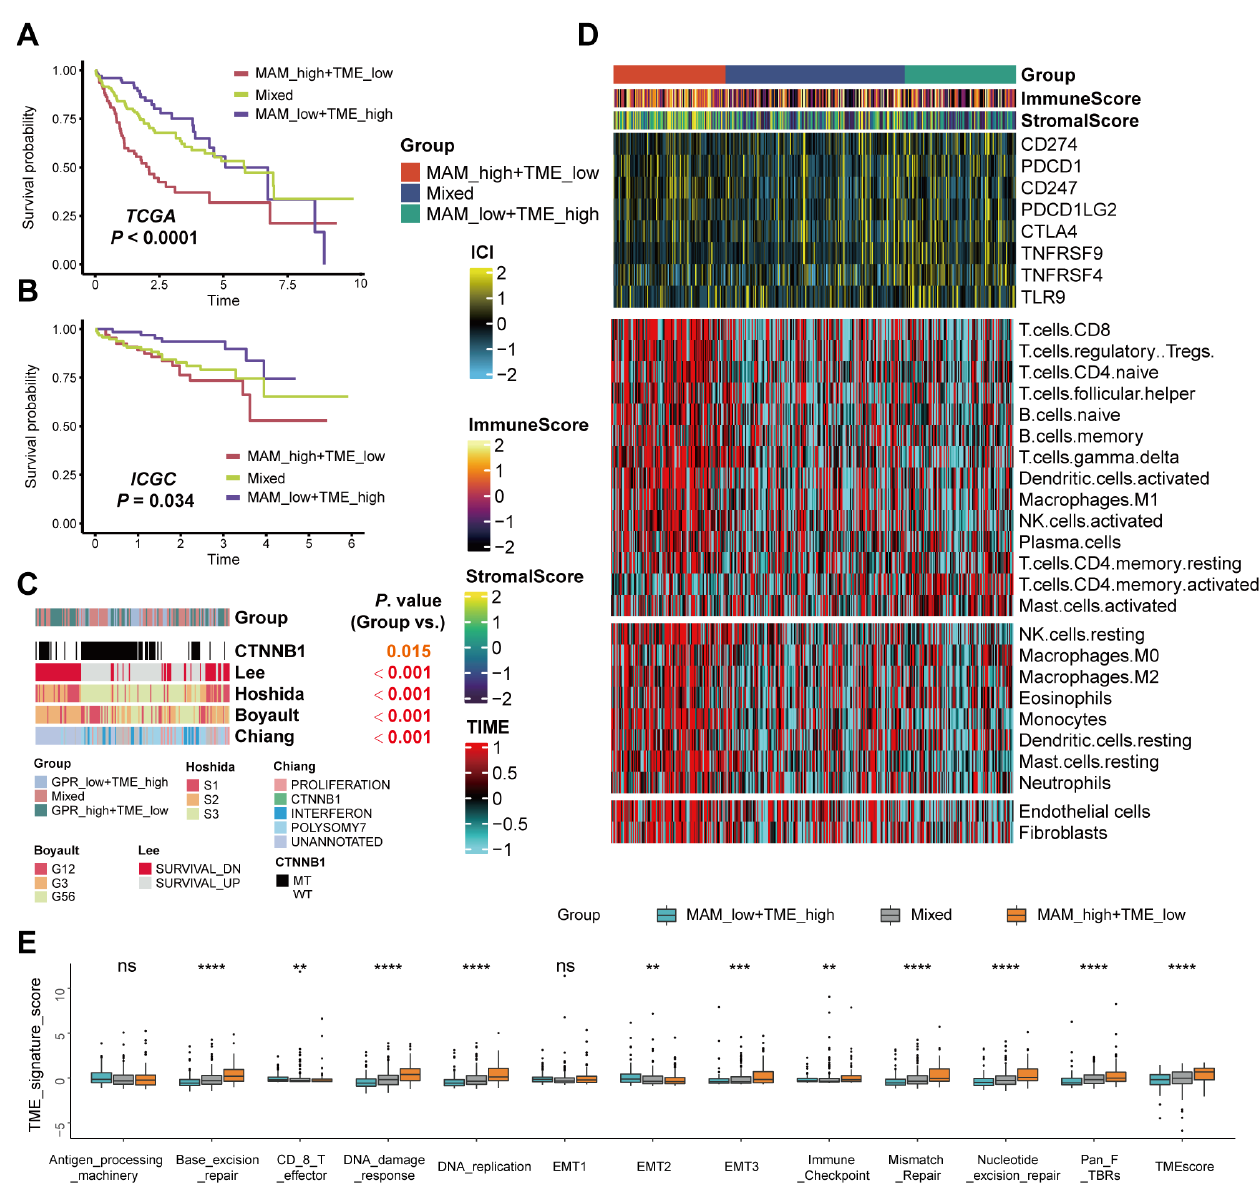
Figure 6. Differences in the tumor microenvironment infiltration between different MAM–TME sub- groups. ( A , B ): KM curves of low-MAM/high-TME-score group, mixed group, and high MAM/low TME group in the TCGA and ICGC datasets. ( C ): Correlations between the combined subtypes and other HCC subtypes. ( D ): Heatmap exhibiting the immune score, stromal score, and several cell types calculated through CIBERSORT analysis of the combined subtypes. ( E ): Tumor immune infiltration signatures of the combined subtypes. ** p ≤ 0.01; *** p ≤ 0.001; **** p ≤ 0.0001; ns, not